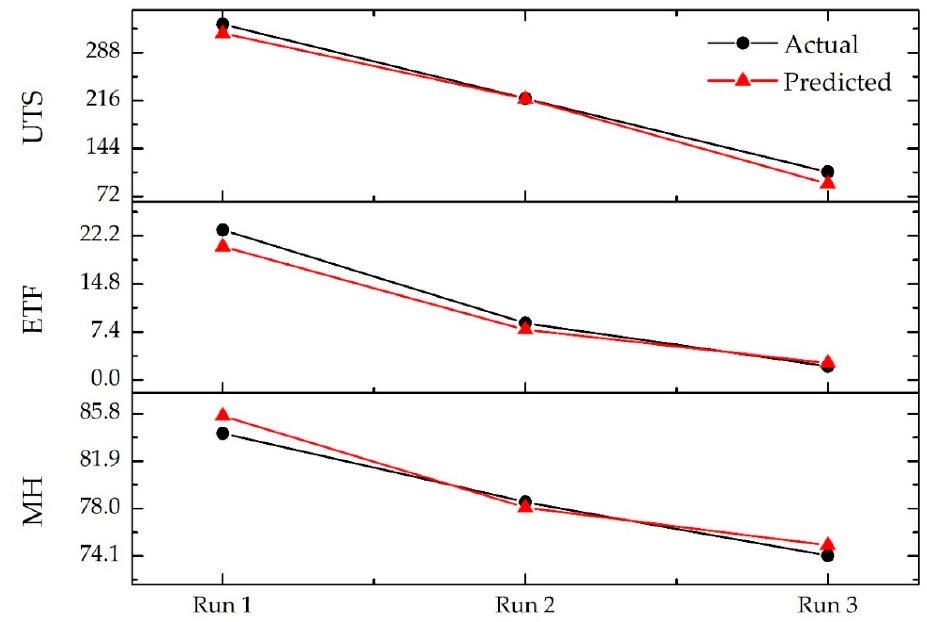
Figure 8. Errors between actual and predicted values in the confirmation runs for UTS, ETF, and MH.